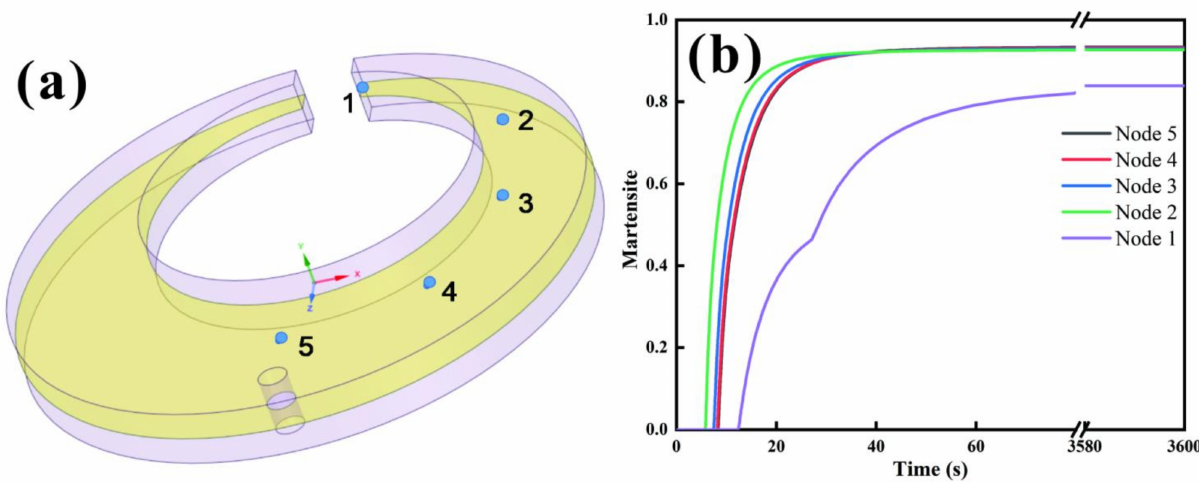
Figure 9. ( a ) Schematic diagram of simulated sites; ( b ) martensite volume versus time graph. The microstructure of the C-ring at different points is shown in Figure 10. As can be seen from Figure 10a, the surface layer has typical carburized layer organization, consisting of black high-carbon needle-like martensite, white-bright residual austenite blocks, and carbides. The matrix is all low-carbon slate-like martensite, with slight differences in the size of the martensite slat bundles depending on the temperature field, but no changes in the tissue composition were found. This indicates that the actual tissue composition was consistent with the simulated martensite